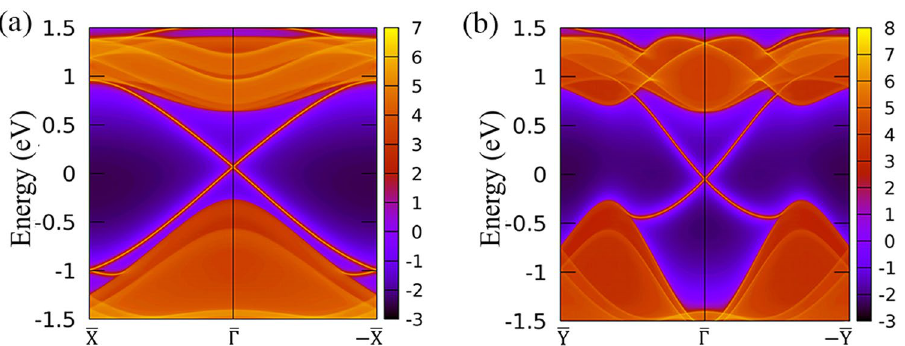
Figure 4. The local density of states of edge states for Bi 2 HF nanosheet with ( a ) the armchair edge and with ( b ) the zigzag